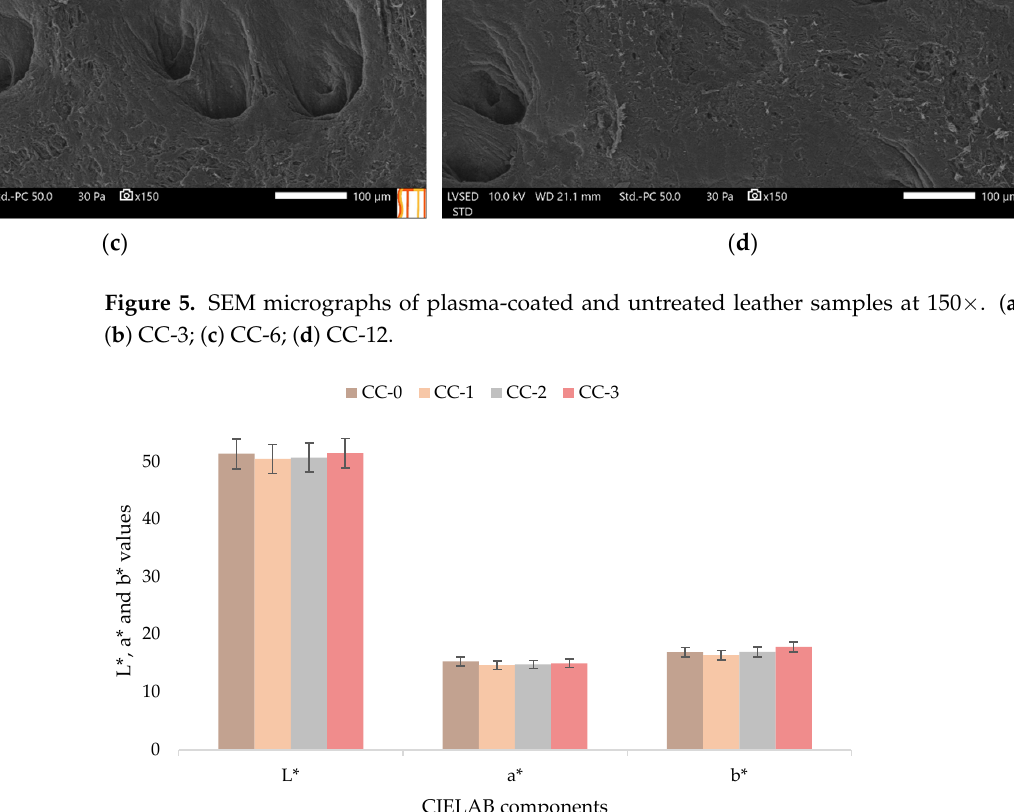
Figure 6. CIELAB component values for coated and uncoated leather samples according to the standard ISO 22700.